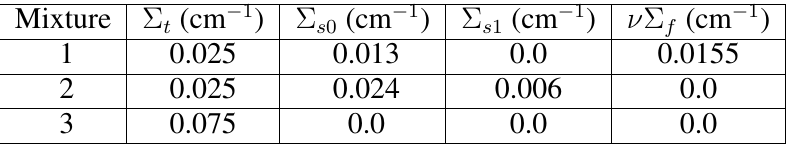
Table 1: Benchmark cross